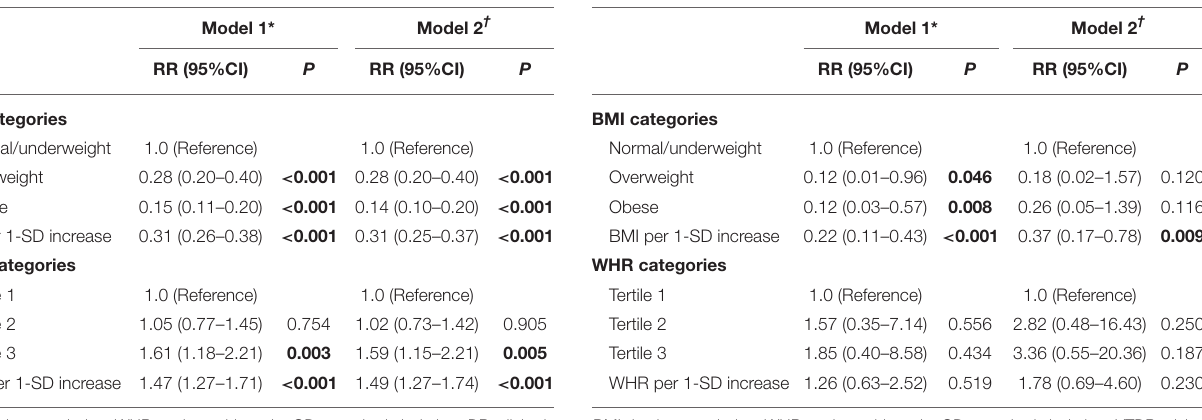
TABLE 2 | Associations between BMI and WHR with the incidence of DR. TABLE 3 | Associations between BMI and WHR with the incidence of